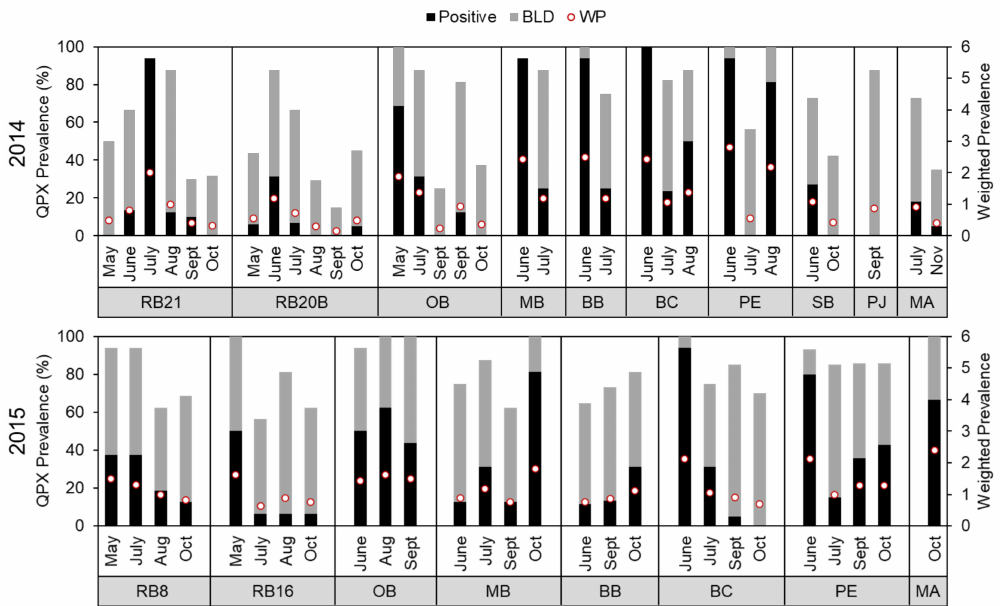
Figure 3. M. quahogii (QPX) prevalence and weighted prevalence (WP) in hard clam tissue samples as determined by qPCR by sampling site and month for 2014 ( top ) and 2015 ( bottom ). Below limit of detection (BLD) represents samples that were positive but could not be accurately quantified. The percentage of positive, quantifiable and positive, BLD samples represents total M. quahogii